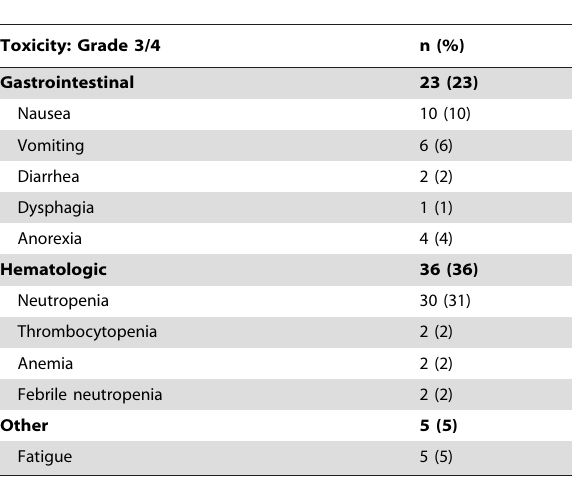
Table 4. Cumulative incidence of Grade 3 + acute complications to NCI CTC 3.0 (during ACT and